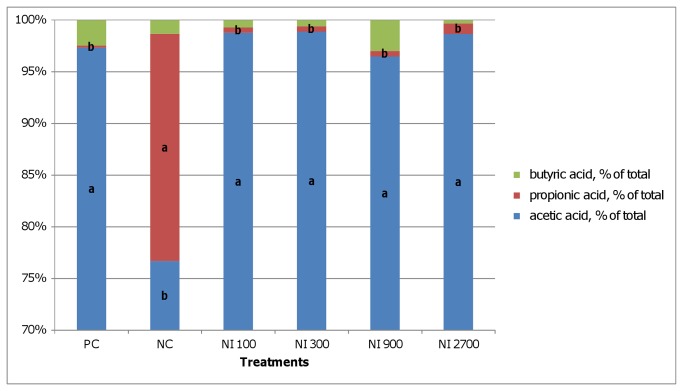
SCFA profiles in crop digesta.PC - positive control (salinomycin, 60 mg/kg); NC - negative control (any additives); NI100 - 100 IU nisin/g (3.2 ml/kg); NI300 - 300 IU nisin/g (9.7 ml/kg); NI900 - 900 IU nisin/g (20.1 ml/kg); NI2700 - 2700 IU nisin/g (87.2 ml/kg); Different letters indicate significant differences between treatments (P≤ 0.05).